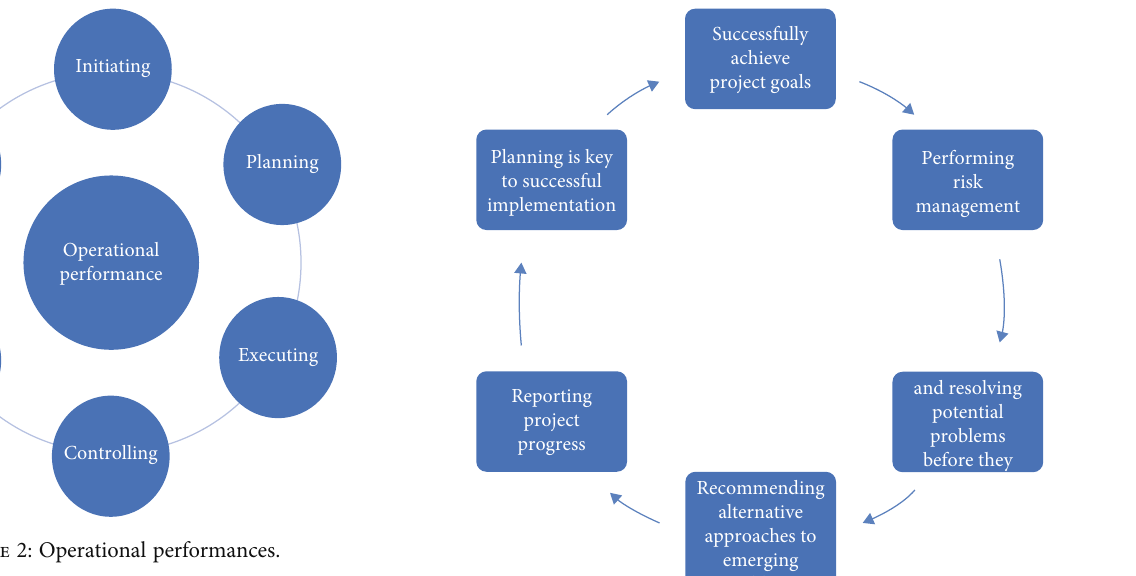
Figure 2: Operational performances.